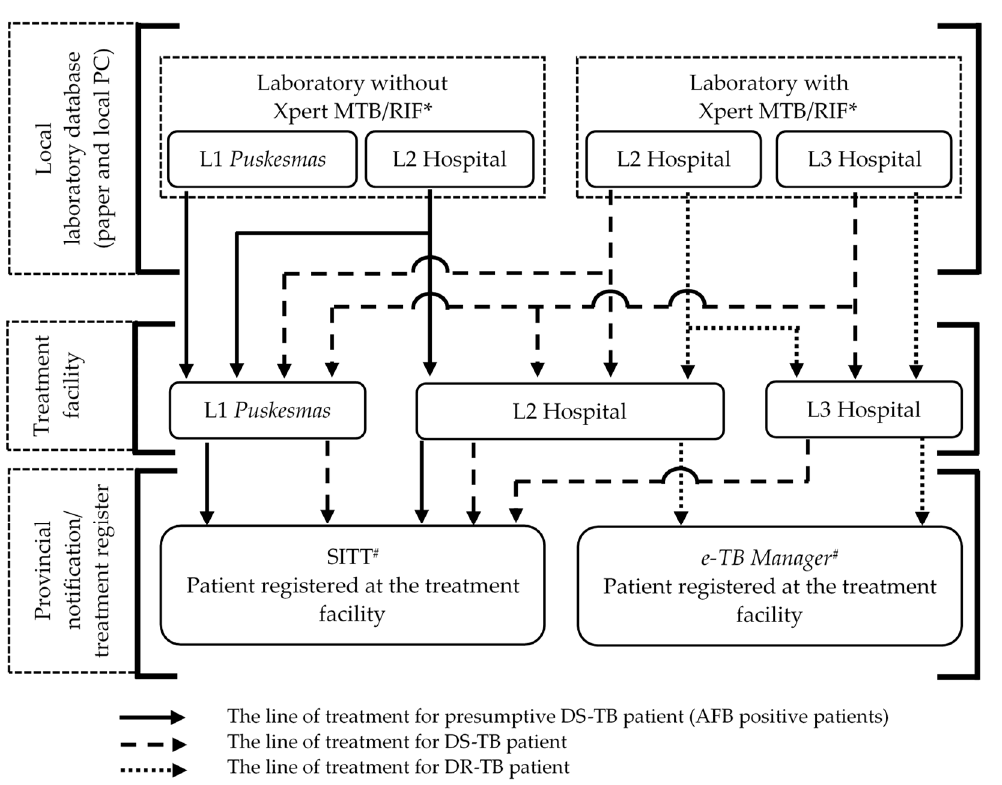
Figure 1. Data sources, referral system, treatment facilities, and provincial treatment register of bacteriologically confirmed TB patients in the provinces of North Sumatra and West Sumatra from 2017 to 2018. DR-TB = drug-resistant tuberculosis, DS-TB = drug-sensitive tuberculosis, e-TB Manager = electronic tuberculosis management information system, PC = personal computer, SITT = Sistem Informasi Tuberculosis Terpadu (integrated tuberculosis information system). * Laboratory data sources; # notification.